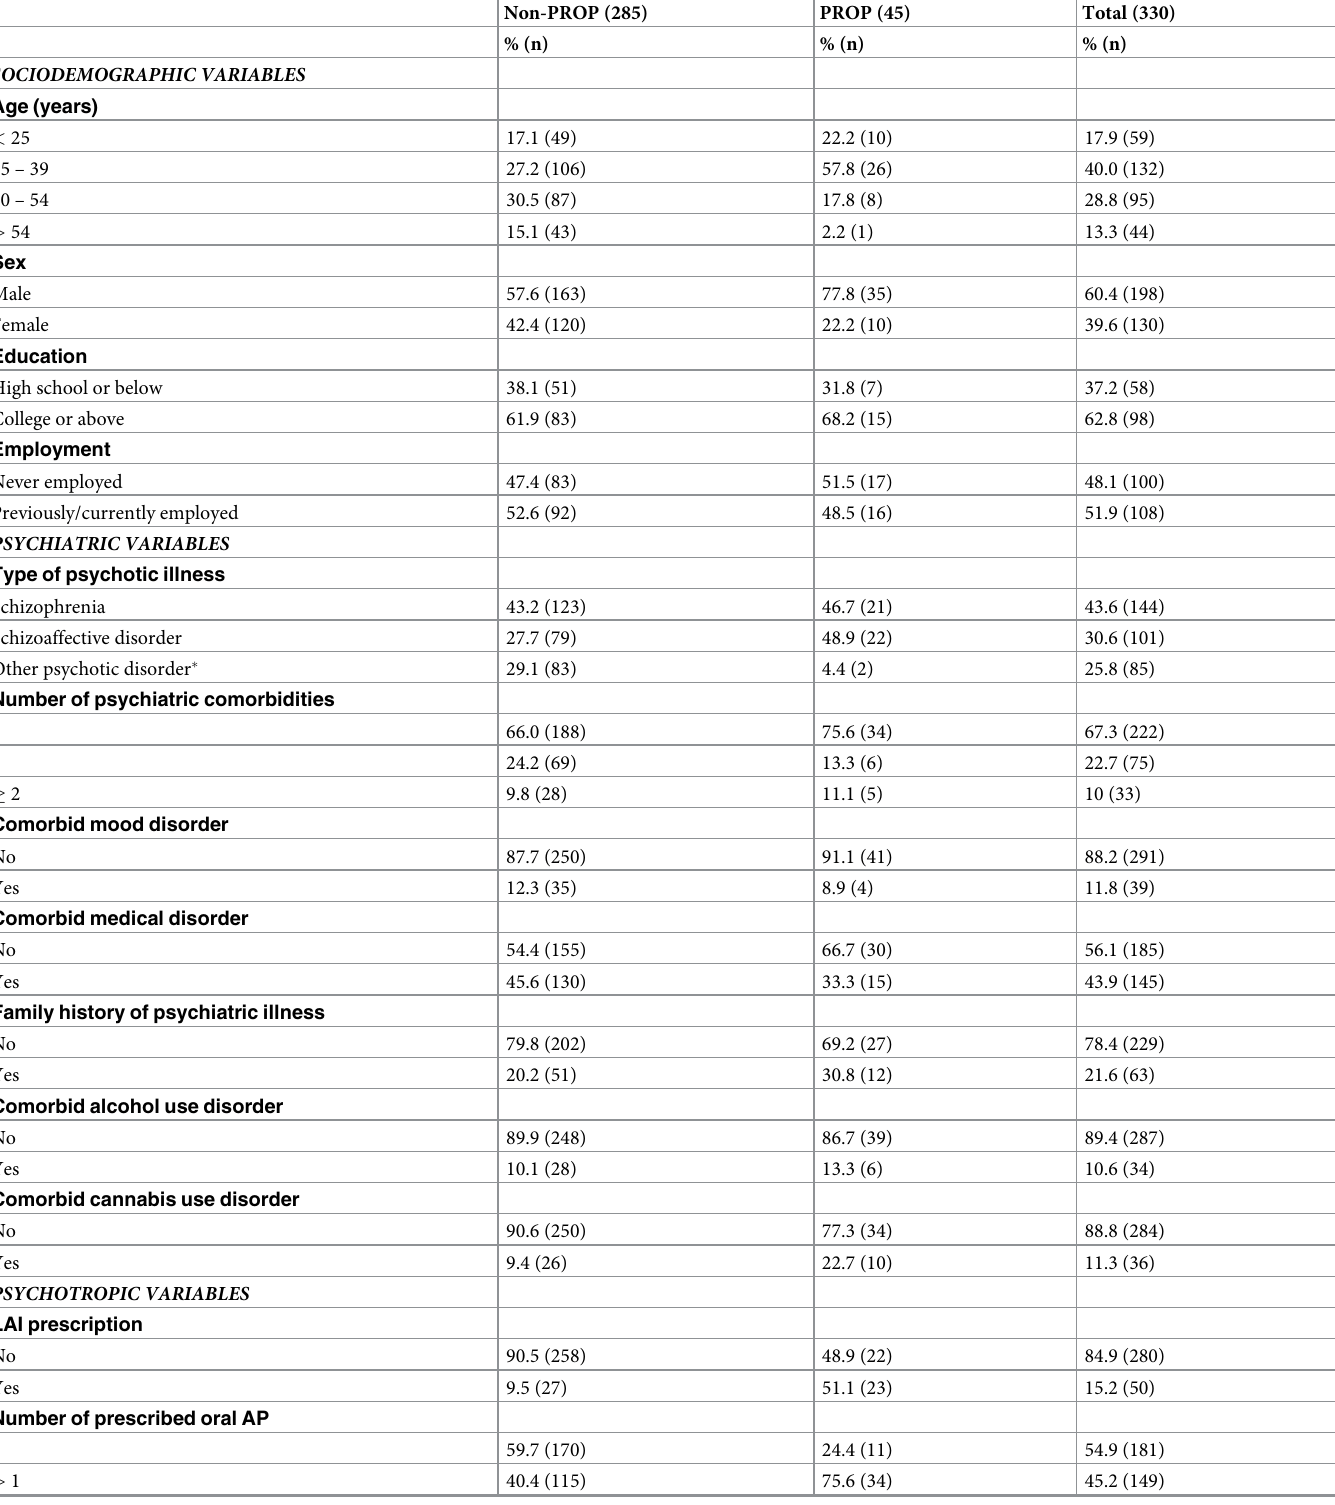
Table 1. General characteristics of patients with a psychotic disorder seen at the outpatient psychiatry department at AUBMC